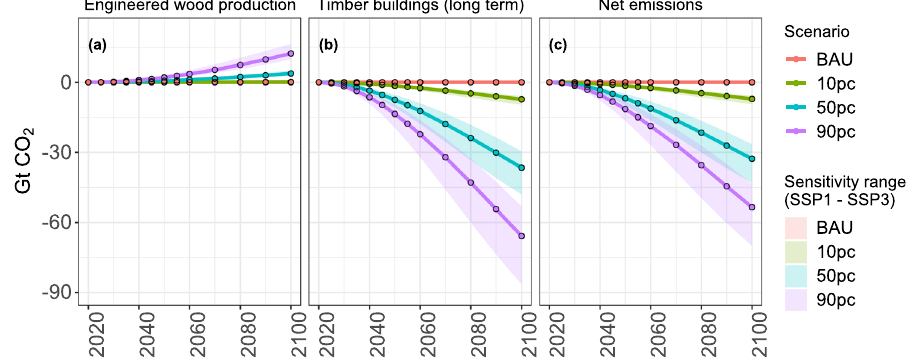
Fig.4|Comparisonofglobalcumulativeemissionsassociatedwithengineered wood usage in novel timber buildings until 2100 with respect to 2020. Solid lines represent emissions in engineered wood demand scenarios in an SSP2 world. The transparent area shows the emission range between SSP1 and SSP3 scenario.